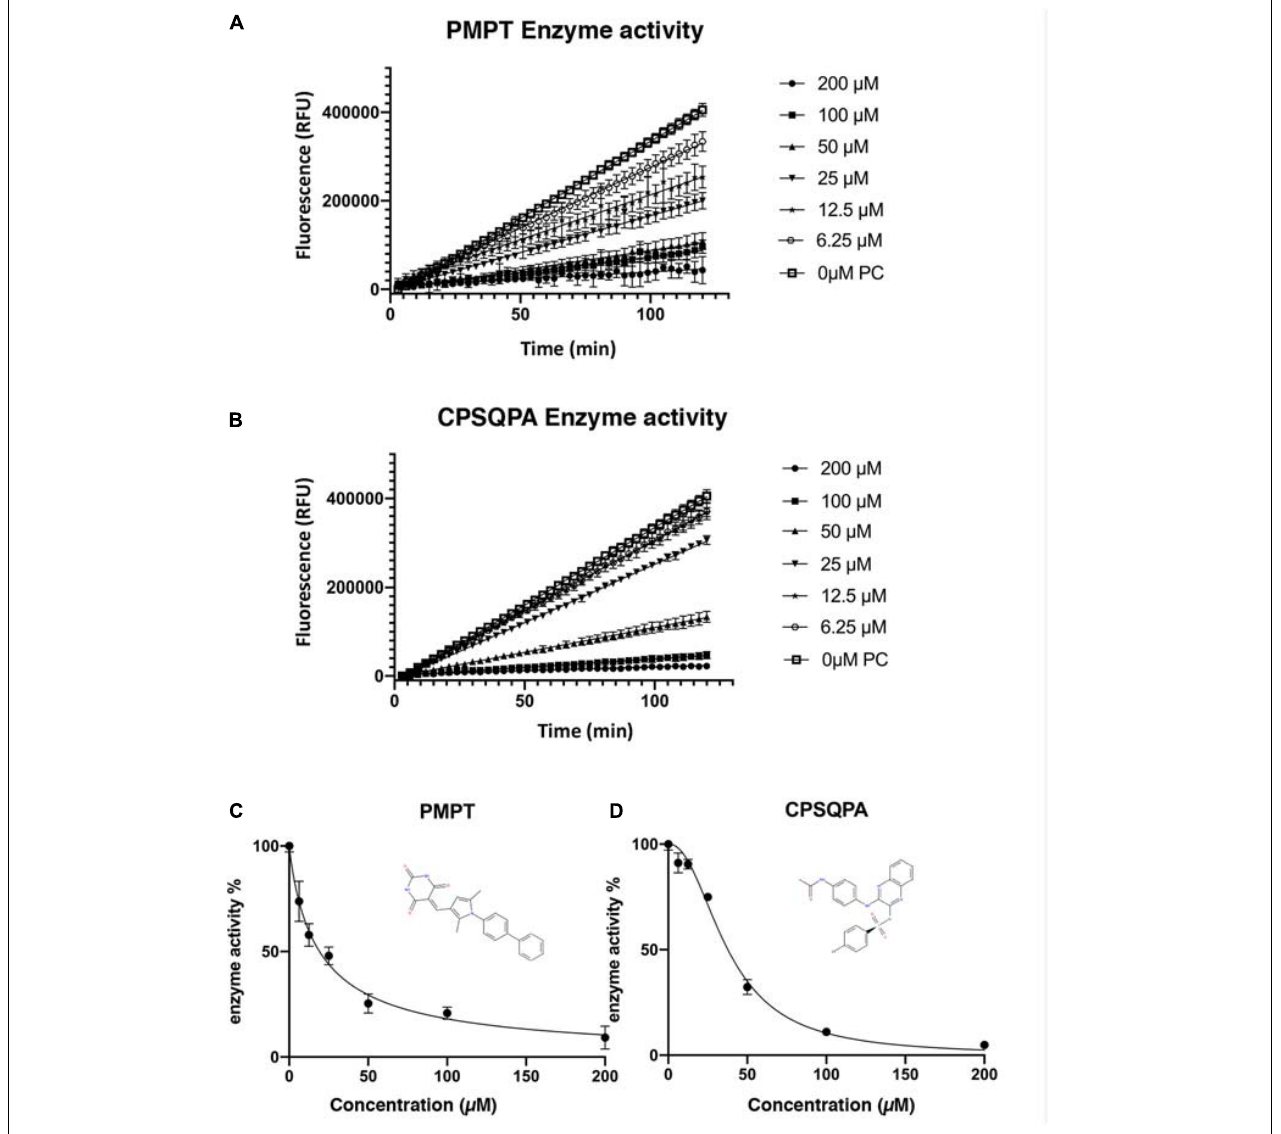
FIGURE 3 | Enzyme activities (A,B) and IC 50 curve (C,D) of newly identified inhibitors, PMPT and CPSQPA. 3CLpro and inhibitors were incubated at 25 ◦ C with slow shaking for 2 h, with fluorescence recorded every 3 min (A,B) . The slope of each curve corresponded to the enzyme activity. Relative enzyme activities were calculated as ratio of compound-treated groups and positive control (no inhibitor) to determine IC 50 . Data analysis and curve fitting were conducted using the program